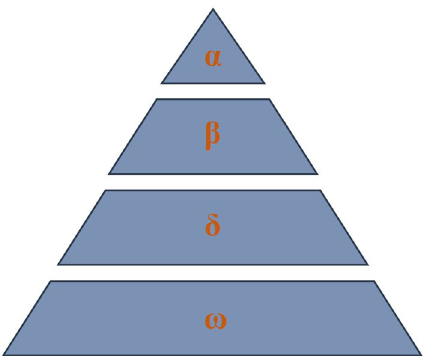
Figure 9. Hierarchy of grey wolf (dominance decreases from the top-down).